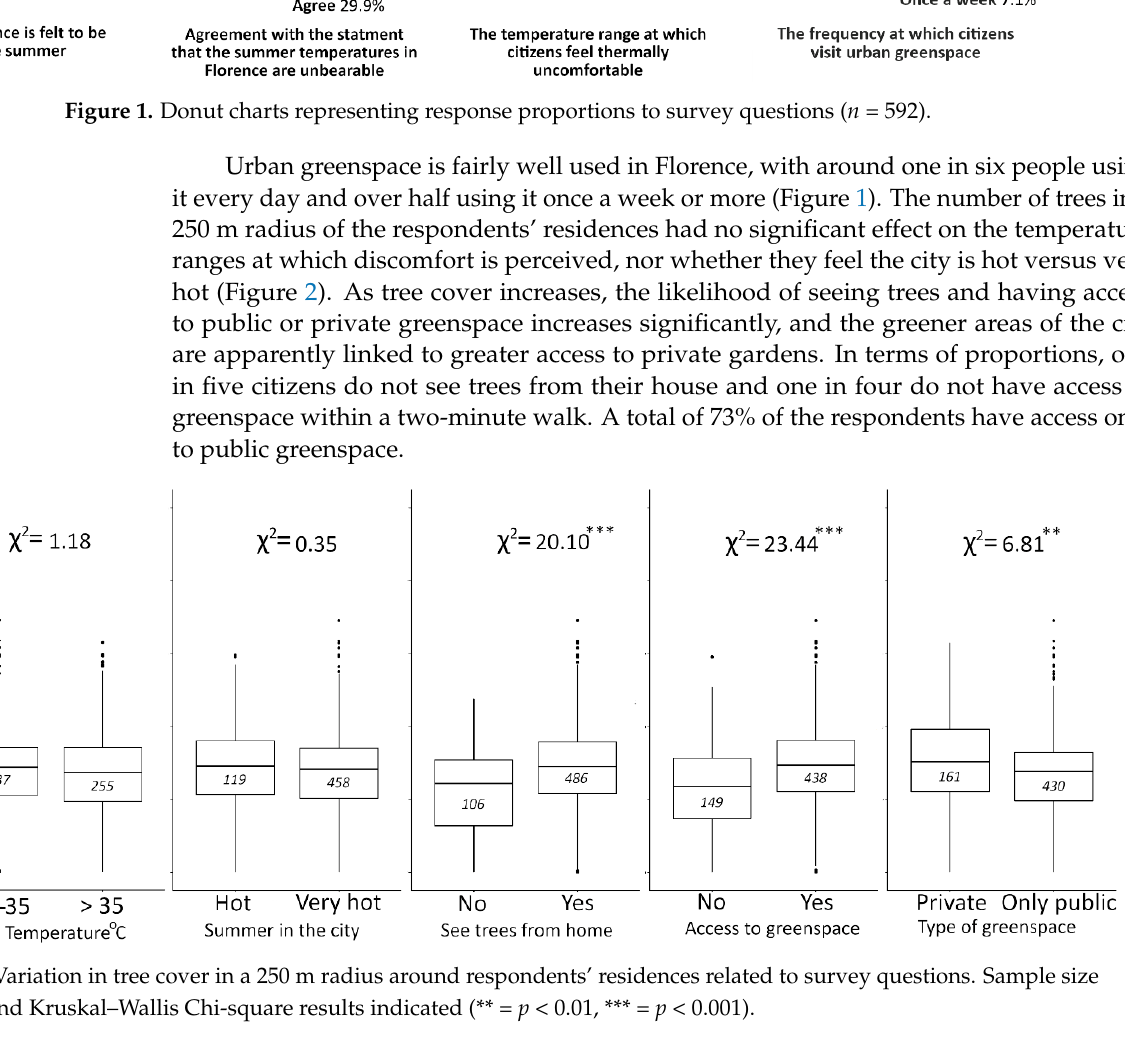
Figure 2. Variation in tree cover in a 250 m radius around respondents’ residences related to survey questions. Sample size in italics and Kruskal–Wallis Chi-square results indicated (** = p < 0.01, *** = p < 0.001).